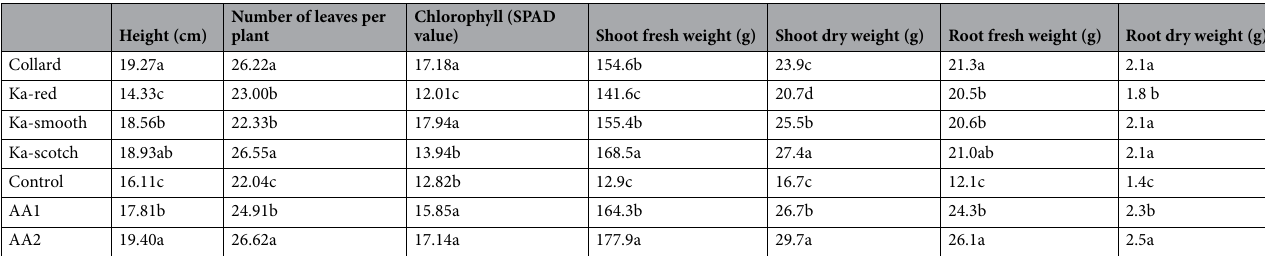
Table 1. The main effect of AA and cultivar on some growth characteristics of cabbages. Control control treatment, AA1 150 mg/L of amino aci, AA2 150 and 300 mg/L of amino acid. Within a column in each treatment means followed by the same letter are not significantly different at P < 0.05 according to the least significant difference